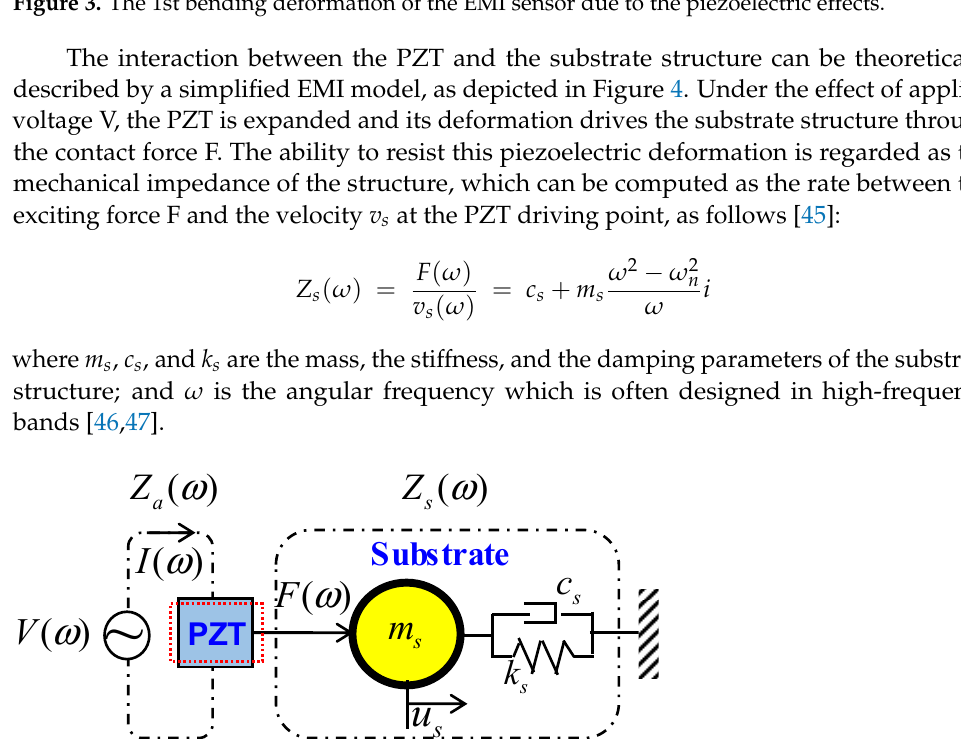
where m s , c s , and k s are the mass, the stiffness, and the damping parameters of the sub- strate structure; and ω is the angular frequency which is often designed in high-frequency bands [46,47].